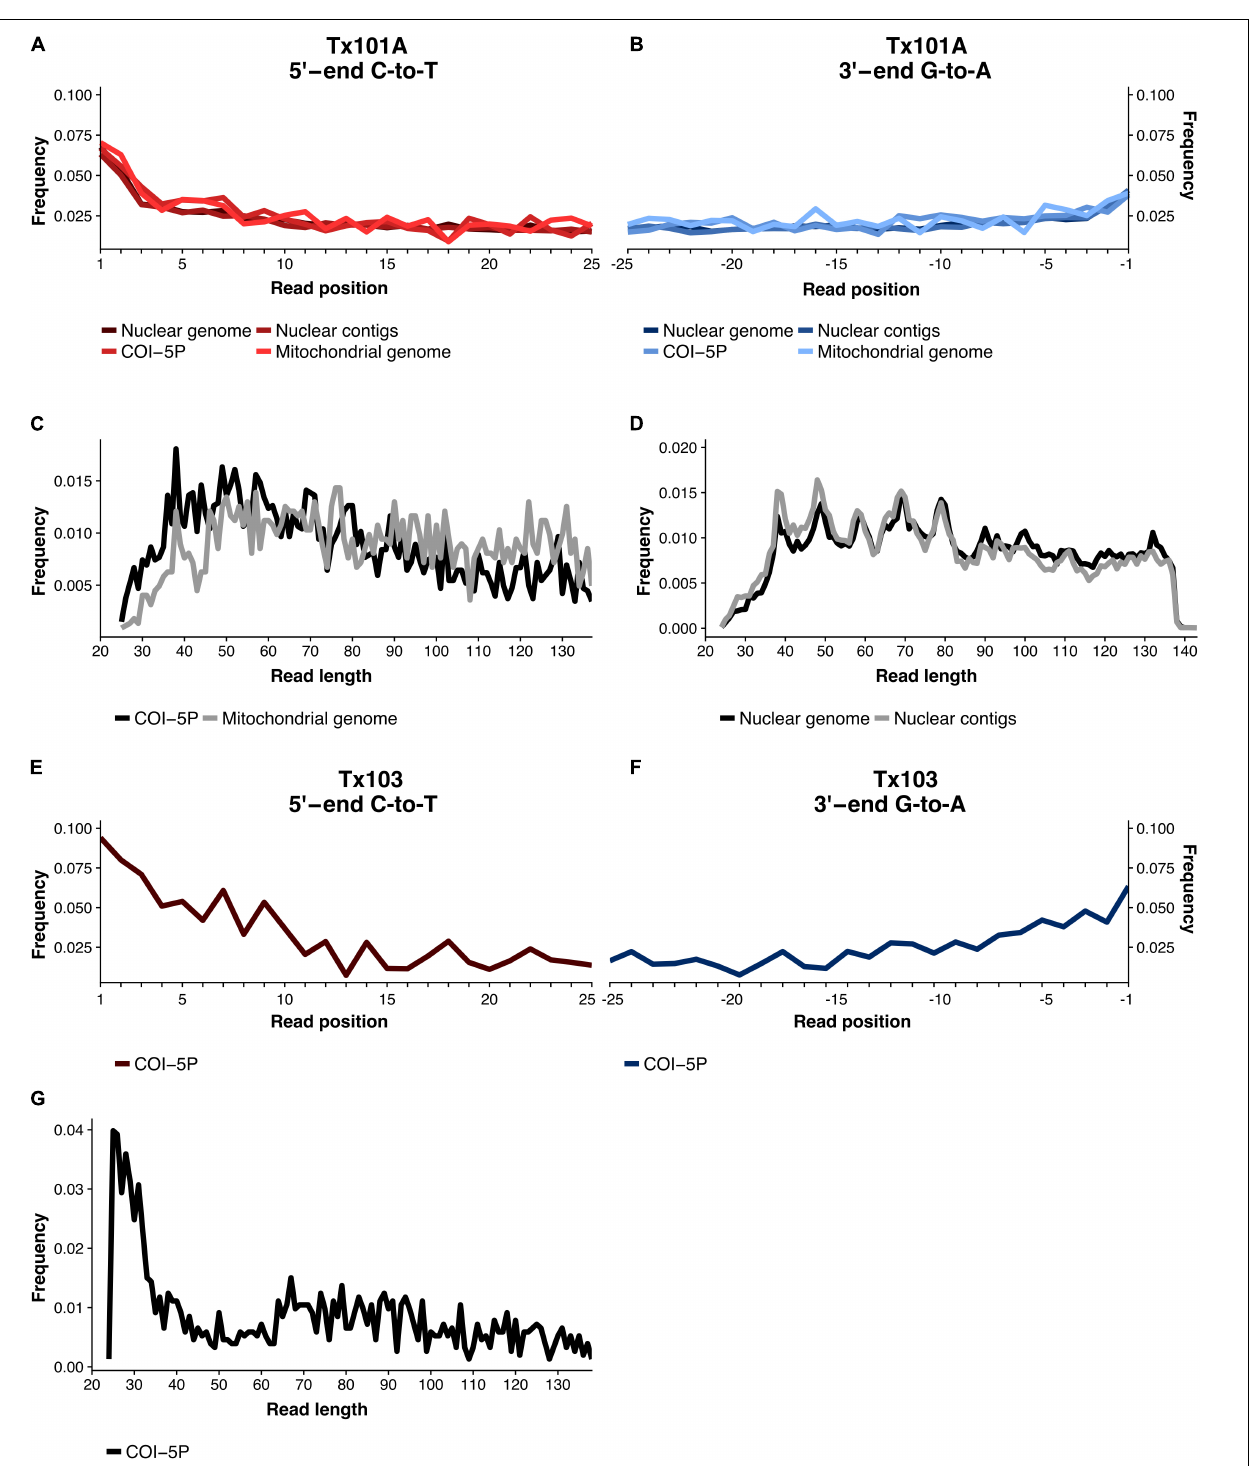
FIGURE 2 | Post-mortem DNA damage patterns. (A) For Tx101A, rates of C-to-T nucleotide mis-incorporation at 5 (cid:48) -read ends, (B) rates of G-to-A at 3 (cid:48) read-ends. (C) Size distribution of reads mapping to mitochondrial, and (D) nuclear reference sequences. (E) For Tx103, rates of C-to-T nucleotide mis-incorporation at 5 (cid:48) -read ends, (F) Rates of G-to-A at 3 (cid:48) read-ends. (G) Size distribution of reads mapping to mitochondrial reference sequences. Only unique high-quality (MQ ≥ 30) reads were considered and mapDamage v.2 was run on the full alignment (100,000 iterations).